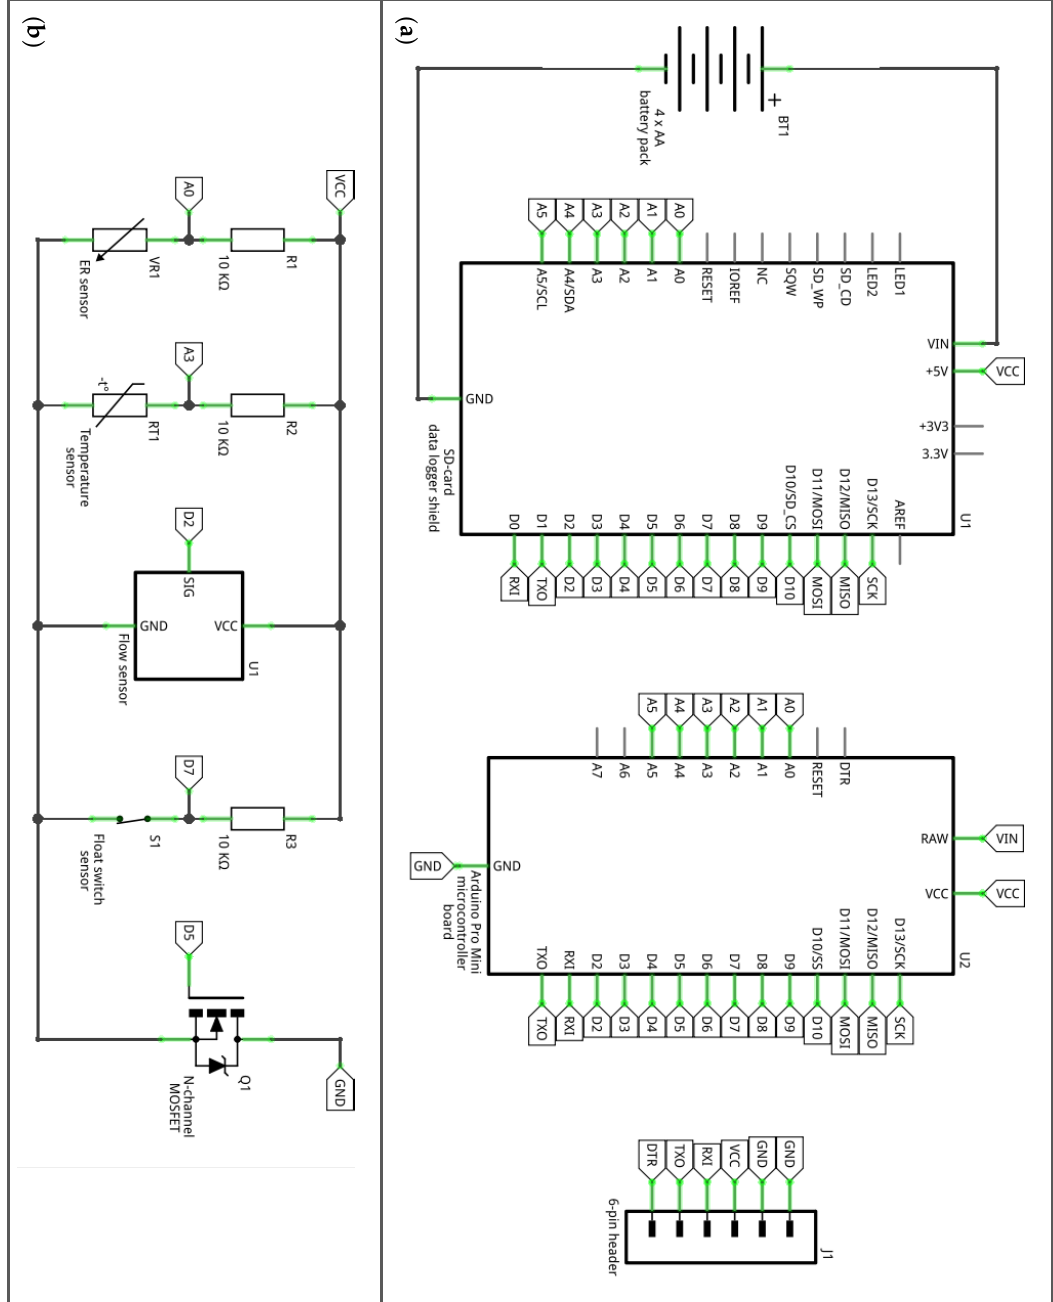
Figure 2. Circuit diagram of the multi-sensor monitoring system: ( a ) the microcontroller board and data logger shield combination and ( b ) the sensors. For the circuit reference designator list, see Appendix A.